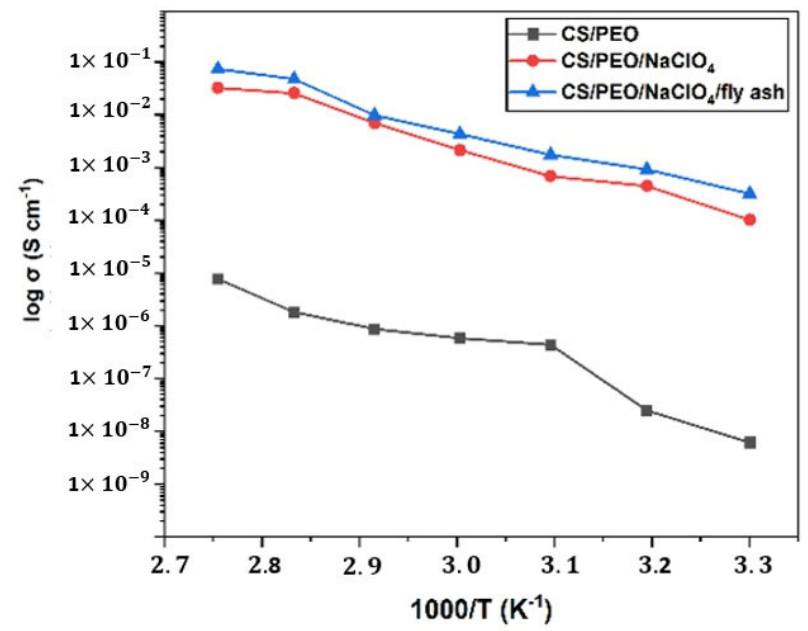
Figure 7. The relationship between temperature and ionic conductivity.